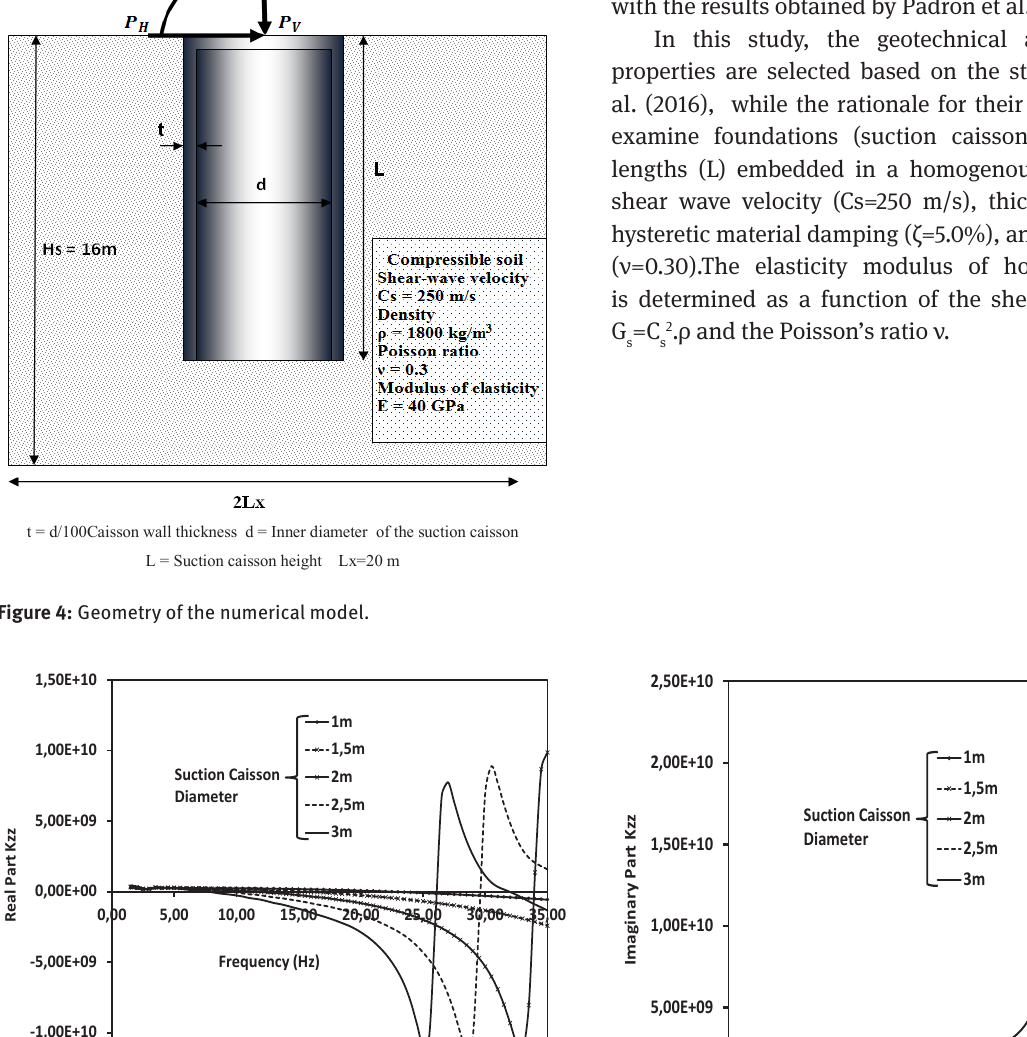
Figure 6 Influence of the suction caisson inner diameter on the horizontal dynamic impedance